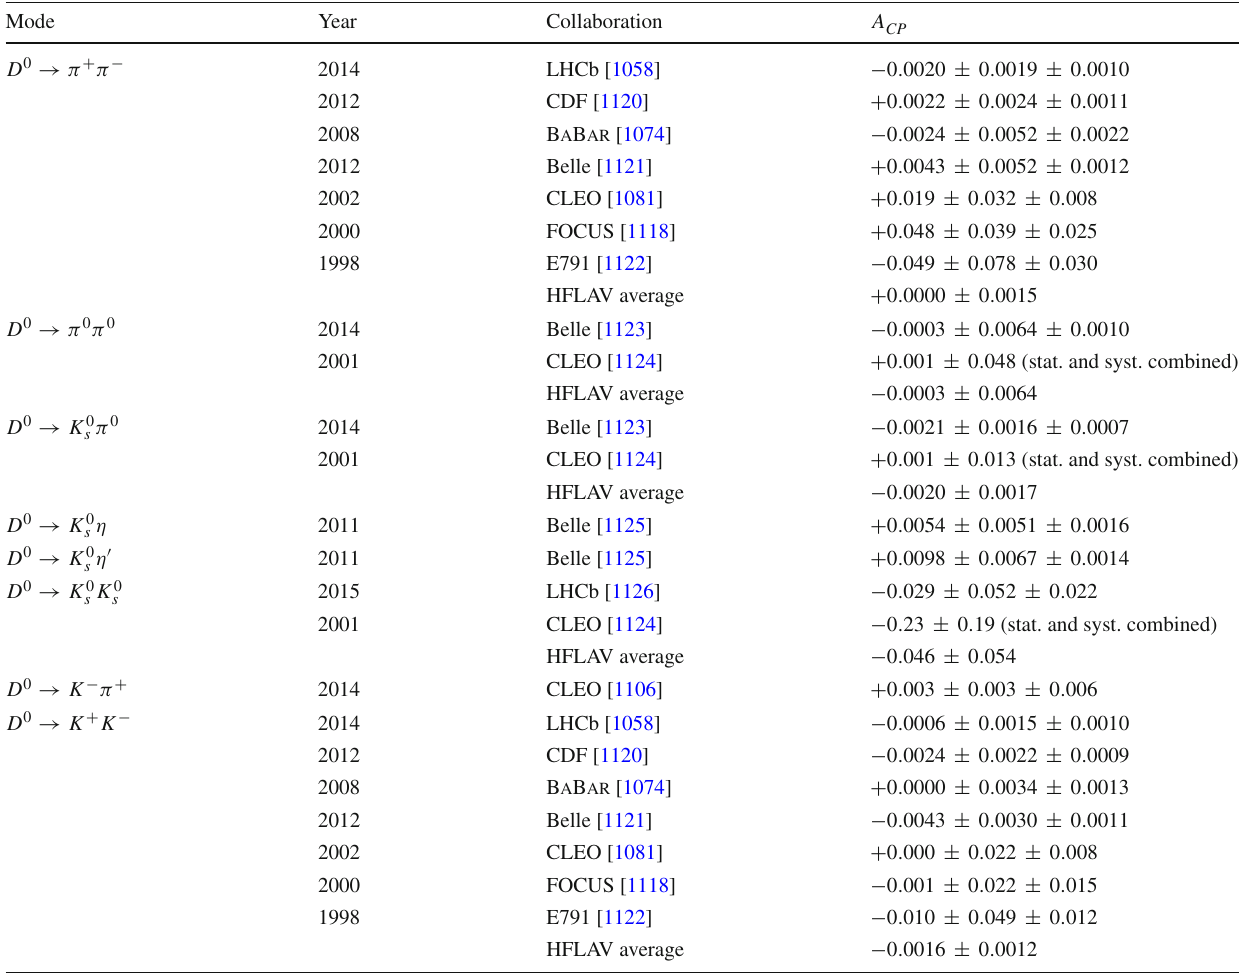
= [ (cid:6)( D 0 ) − (cid:6)( ¯ D 0 ) ] / [ (cid:6)( D 0 ) + (cid:6)( ¯ D 0 ) ] for two-body D 0 , ¯ D 0 decays CP